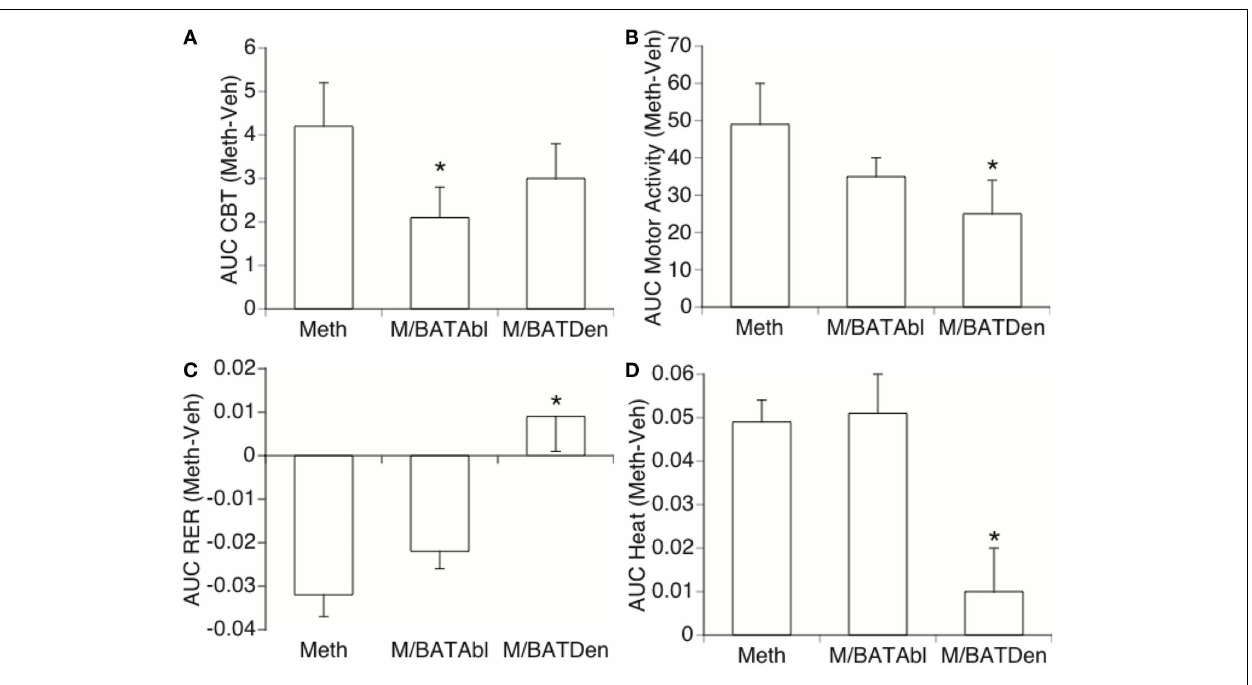
denervation. Stress peak (first hour) was excluded.Values represent the average difference between Meth-injected andVehicle-injected respective controls ± SEM, for six animals/group. * p < 0.05, ANOVA followed by Bonferroni’s post hoc test, n = 6